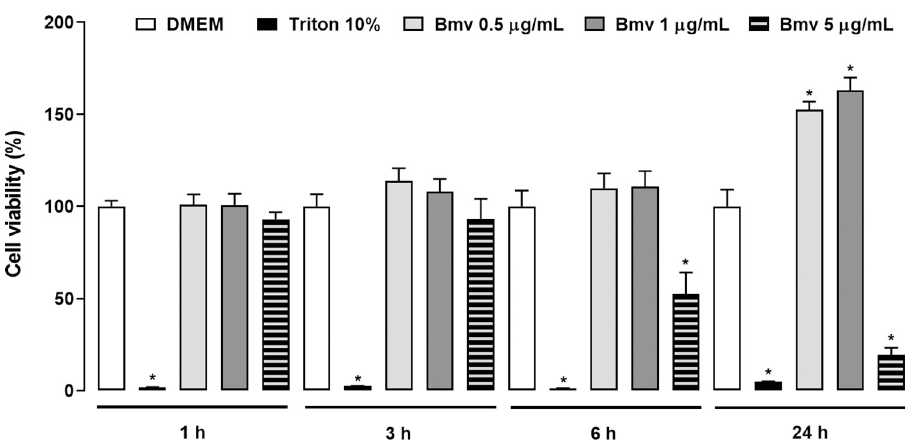
Fig 1. Time course of Bmv-induced effect on viability of preadipocyte cell culture. 3T3-L1 preadipocytes (2 x 10 5 cells/well) were incubated with Bmv (0.5–5 μ g/mL) or DMEM (control) for 1, 3, 6 and 24 h. Metabolic activity was assessed by the MTT assay. Results are expressed as mean + S.E.M. of 3 independent assays (n = 4). � p < 0.05 vs control (ANOVA and Bonferroni post test).